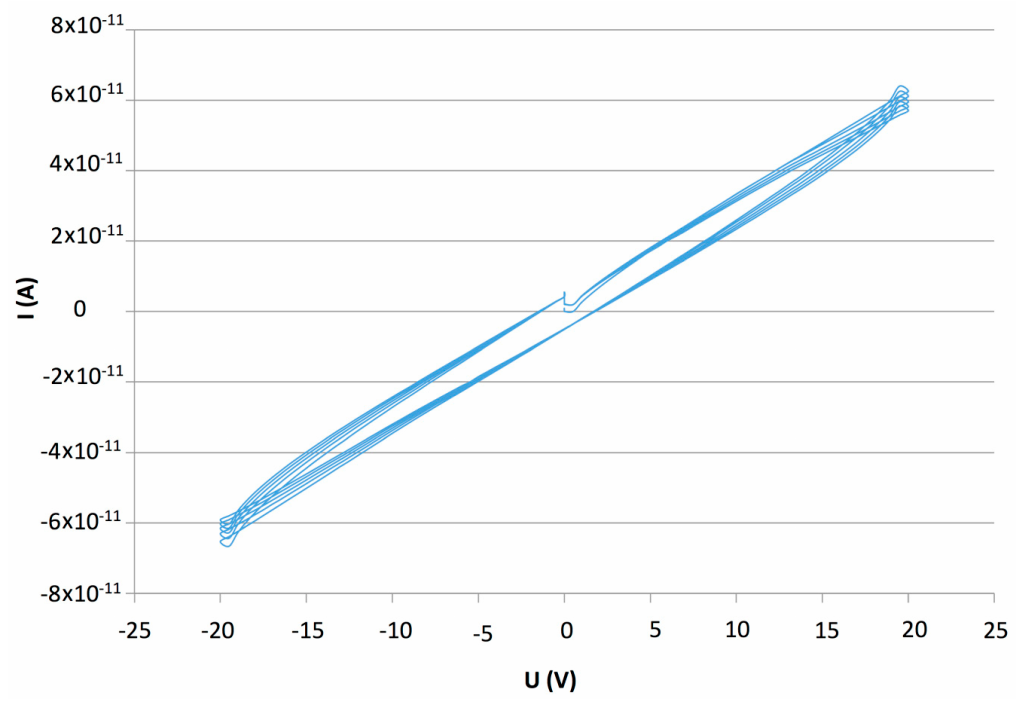
device (E4), between − 25 V to +25 15